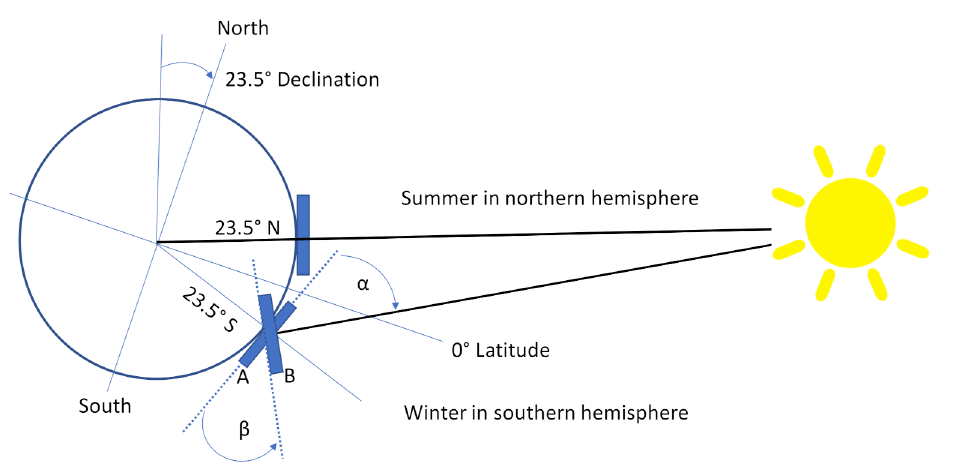
Figure 17. Solar incidence angle on a PV array in winter conditions, where the PV array is in the southern hemisphere and the Sun’s orbit is in the northern hemisphere. (A) Local horizontally mounted PV array. (B) Locally tilt-mounted PV